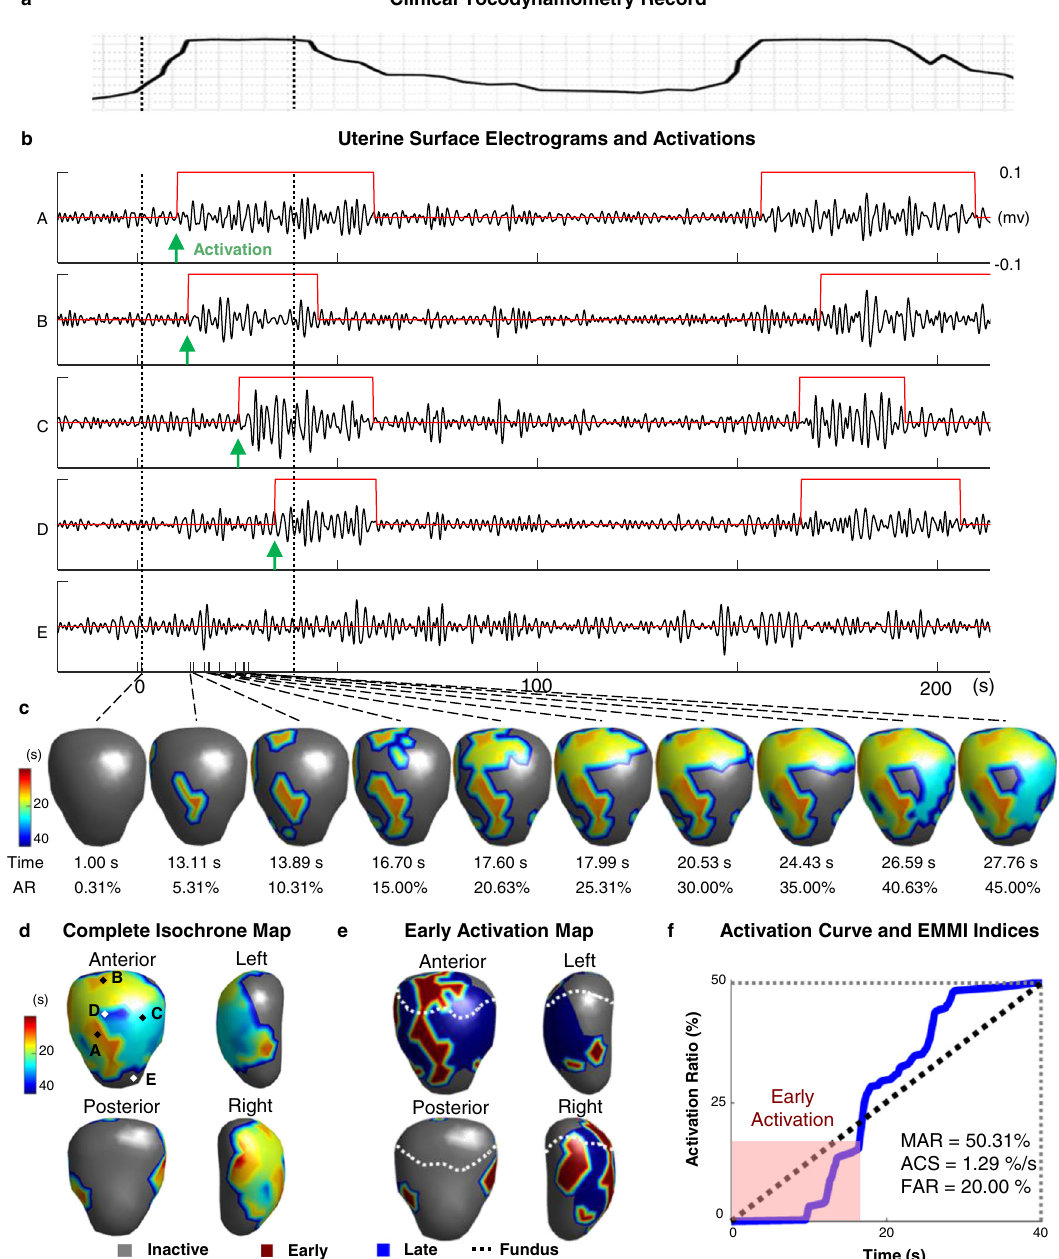
Fig. 3 | Quanti fi cation of contractions with electrograms on the uterine sur- faces. a For a contraction in Subject #2 that the clinical TOCO monitor con fi rmed, b the electrical activations are de fi ned as the initiation of UEB in the multichannel electrogramsatabout320uterinesitescoveringtheentireuterinesurface.Inthe5 representativeuterineelectrogramsfromtheindicatedsitesmarkedAthroughEin d ,redsteplinesdenotetheUEB,greenarrowsdenotetheelectricalactivations,and the dashed black lines denote the earliest and latest electrical activations. c The entire activation process is visualized by the generation process of the uterine activationisochronemapandtheactivationcurve.Theformershowstheactivation locationandtimeacrossthe3Duterinesurface;thelattershowshowtheactivation ratio increases over time. It occurs during the fi rst part of the TOCO signal of contraction. d The complete isochrone map re fl ects the electrical activity of the